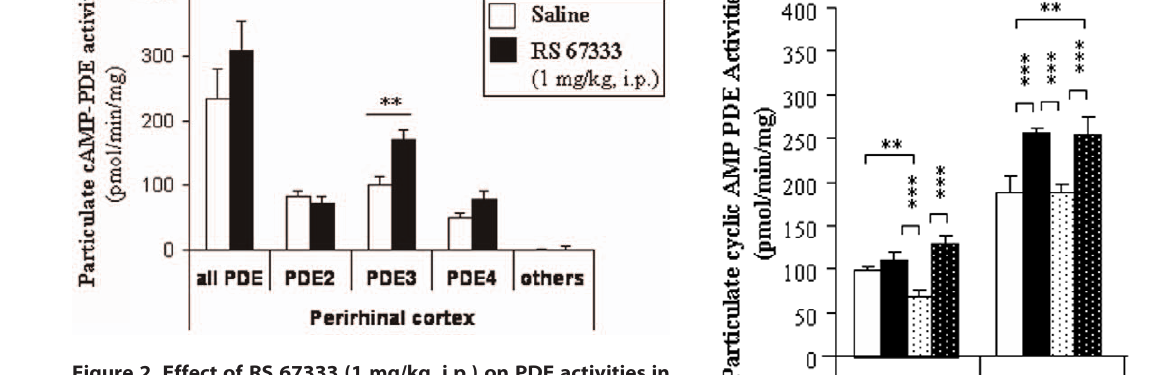
Drug treatments lower cAMP levels in hippocampus, prefrontal cortex and perirhinal cortex after the object recognition test